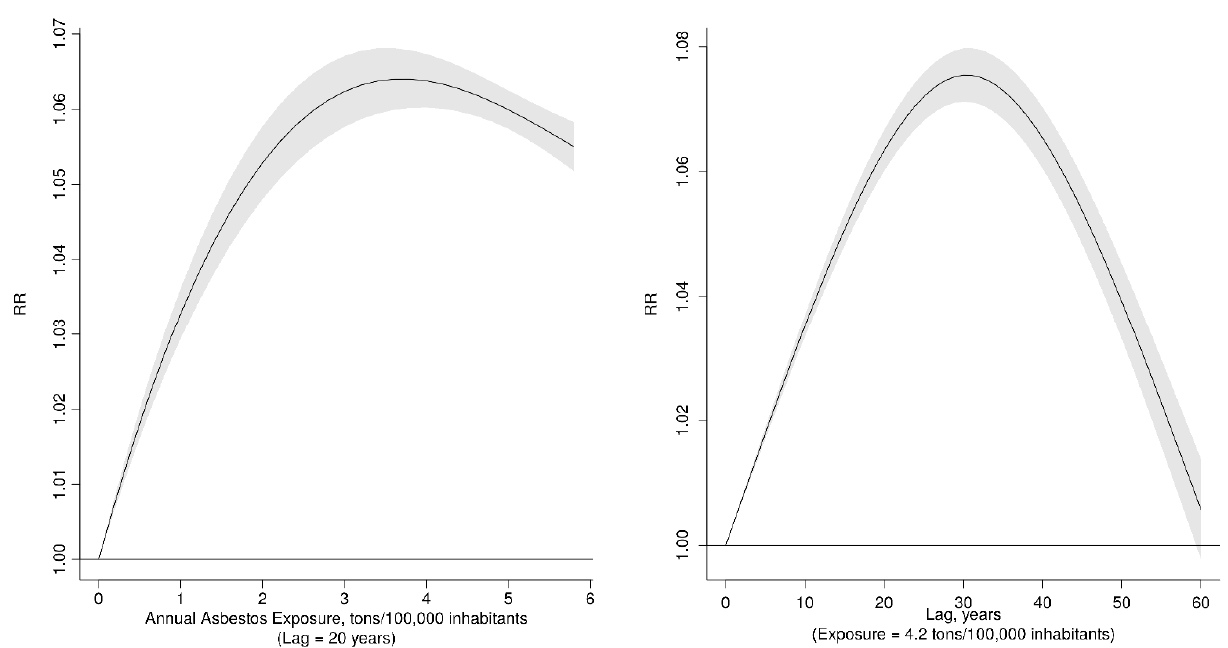
Figure 4. Exposure–response curve at lag 20 years ( left ) and lag–response curve for annual asbestos exposure of 4.2 tons/100,000 inhabitants ( right ), with 95% CI.